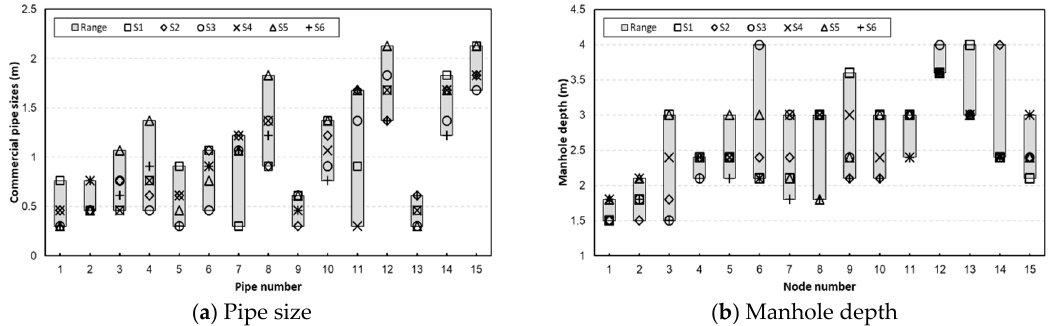
Figure 7. Optimal component dimensions obtained from the scenario-optimal solutions. ( a ) pipe size and ( b ) manhole depth.